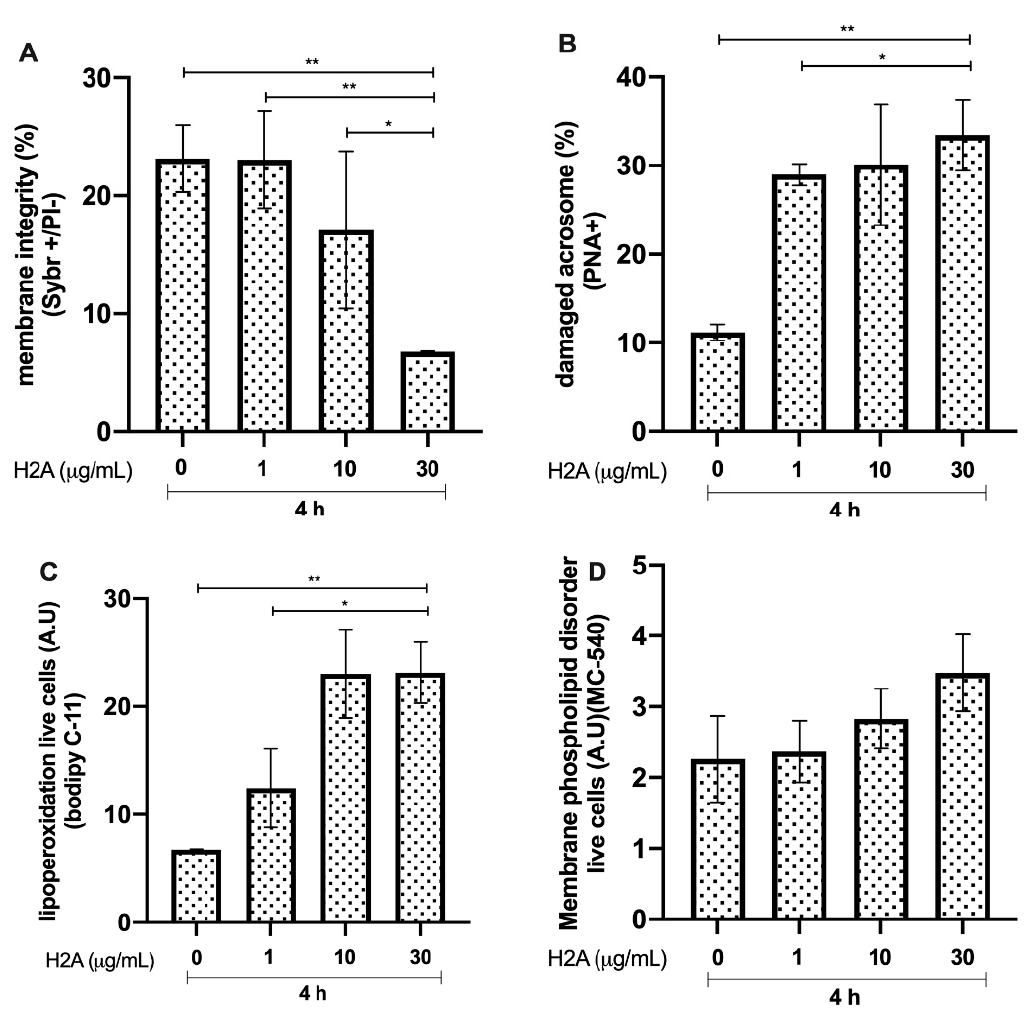
Figure 2. Effect of different concentrations of histone 2A (H2A) on bull sperm. ( A ) Plasma membrane integrity. ( B ) Damaged acrosomes. ( C ) Lipid peroxidation. ( D ) Membrane phospholipid dis- order. The results are shown as the mean ± standard deviation. The asterisks (*, **) above the bars indicate differences between the groups ( p < 0.05, p < 0.01, and p < 0.0001) based on three biological replicates.